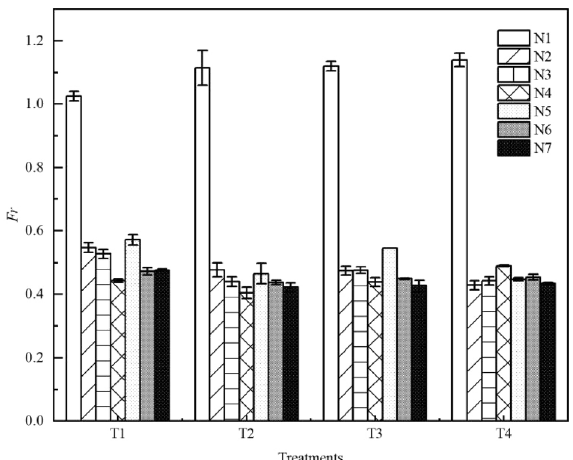
Figure 5. Comparison of the Froude constant Fr between seven types of litter layer. Fr is the Froude constant; N1–N7 are treatments, see Table 2 for treatment specifics; T1 is slope 5°, rain intensity 60 mm·h −1 ; T2 is slope 10°, rain intensity 60 mm·h −1 ; T3 is slope 5°, rain intensity 120 mm·h −1 ; T4 is slope 10°, rain intensity 120 mm·h −1 . Error bars indicate standard deviation.